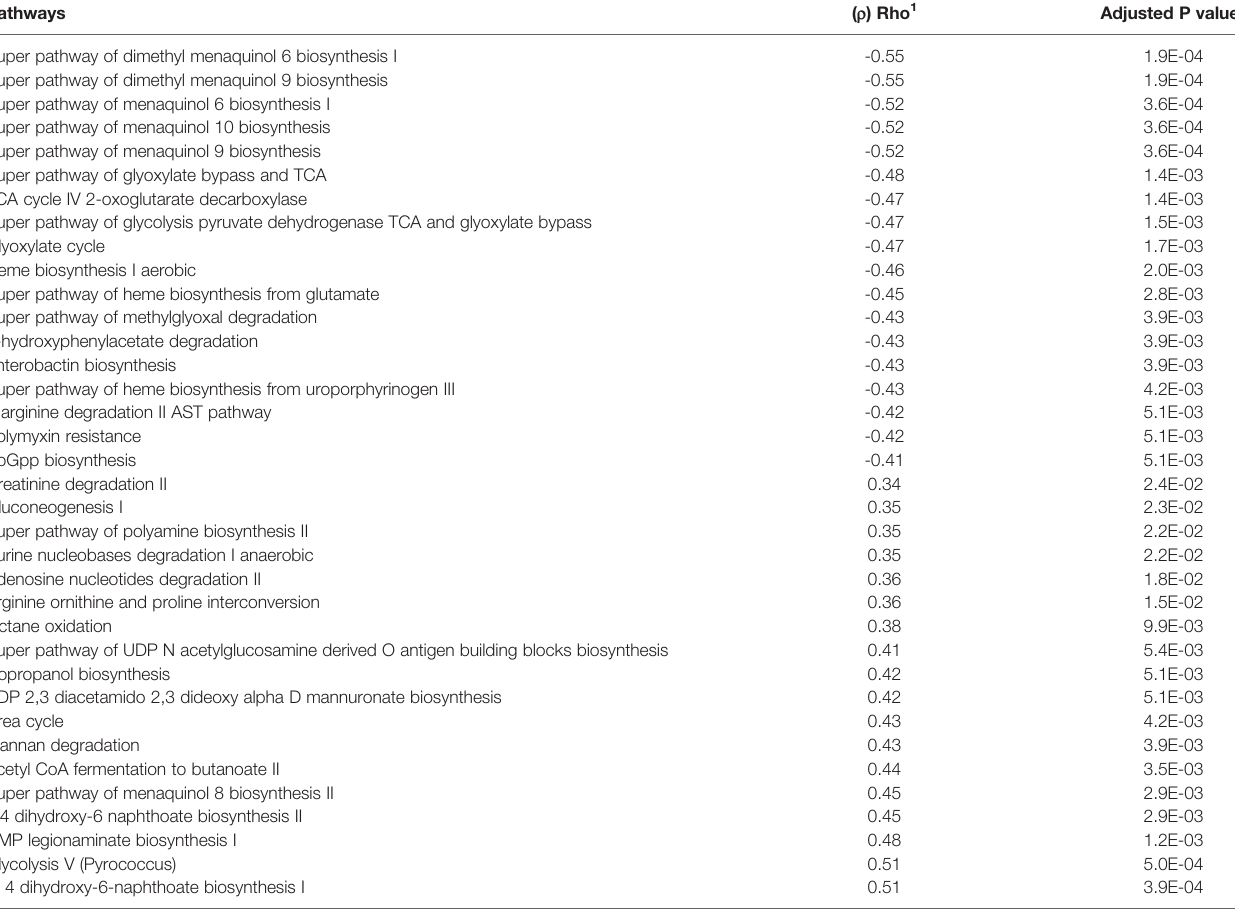
TABLE 1 | Correlation between predicted metagenomic pathways abundance at day 28 of the study and chronological age in months.